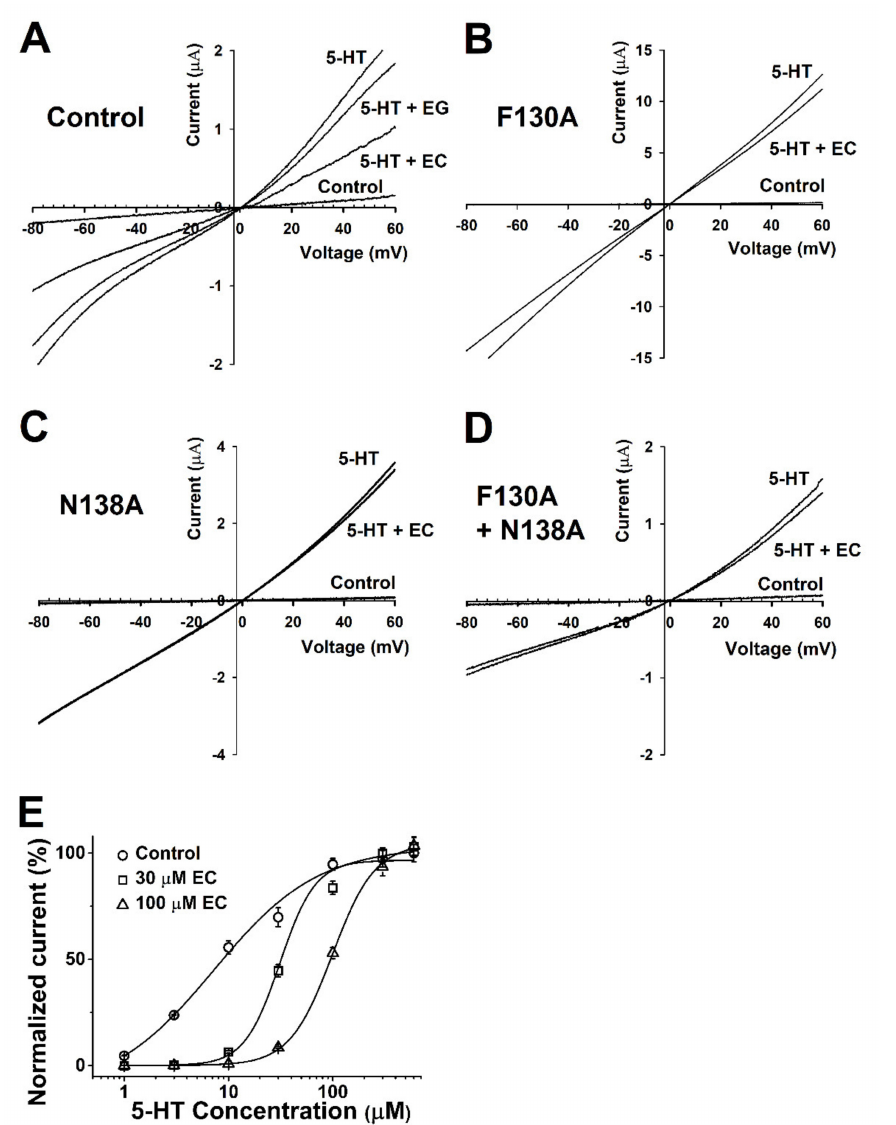
Figure 4. Voltage dependency and competition inhibition of chanoclavine in I 5-HT in oocytes express- ing 5-HT 3A receptors. ( A – D ). Current–voltage relationship of I 5-HT inhibition by chanoclavine in 5-HT 3A receptors. Wild-type 5-HT 3A receptor traces showed a current–voltage relationship with EC and EG at the same concentration as 5-HT (100 µ M). All control trace voltage ramps change with only the bath solution flowing without treatment. Traces were obtained using voltage changes from − 80 mV to +60 mV over a duration of one sweep per two seconds. B – D Indicate F130A, N138A, and F130A+N138A, respectively. ( E ). Concentration-response effect of 5-HT in the absence or presence of chanoclavine on oocytes expressing human 5-HT 3A receptors. Control ( ) represents various 5-HT (cid:35) concentration currents from 1 to 100 µ M in the absence of chanoclavine, and 5-HT at 30 µ M ( (cid:3) ) and 100 µ M ( (cid:52) ) chanoclavine represents the change in the current compared to the control. Normalized currents were divided by the I max of the control current and the I max of 5-HT alone, with 30 µ M and 100 µ M EC at 99.1 ± 14.2, 94.6 ± 24.4, and 60 ± 2.2, respectively. Oocytes were exposed to 5-HT alone or with EC over a duration of 2 mL per minute and held at a − 80 mV membrane holding potential. Each value represents the mean ± SEM ( n = 8–10 from four different